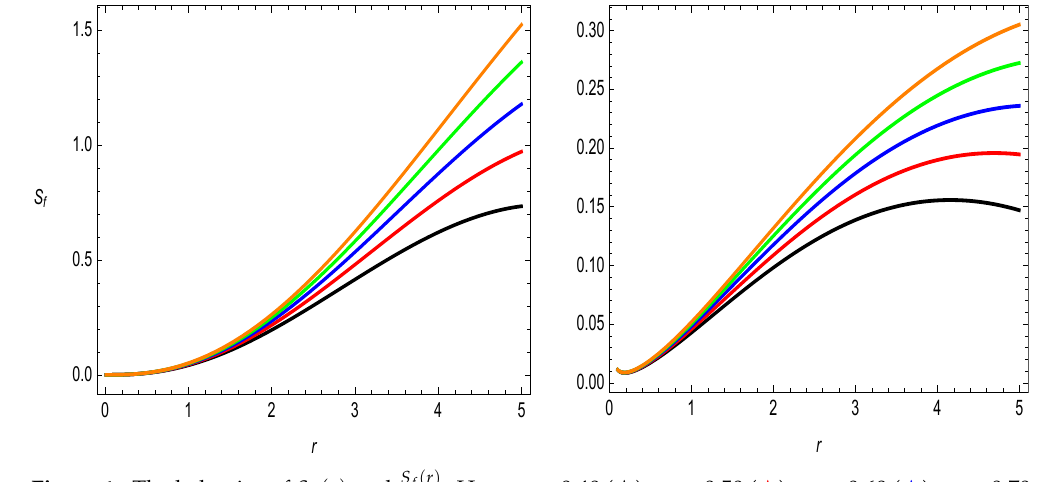
Figure 1. The behavior of S f ( r ) and S f ( (cid:70) ), α = 0.80 ( (cid:70) ), and γ = 0.10.